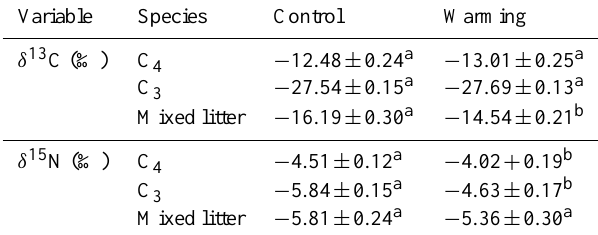
Table 2. The values of δ 13 C and δ 15 N of litter of C 3 , C 4 species and mixed litter under the warming treatment. Data are expressed as mean ± SE, n = 6. Different letters indicate statistical significance at P < 0 . 05 between the two